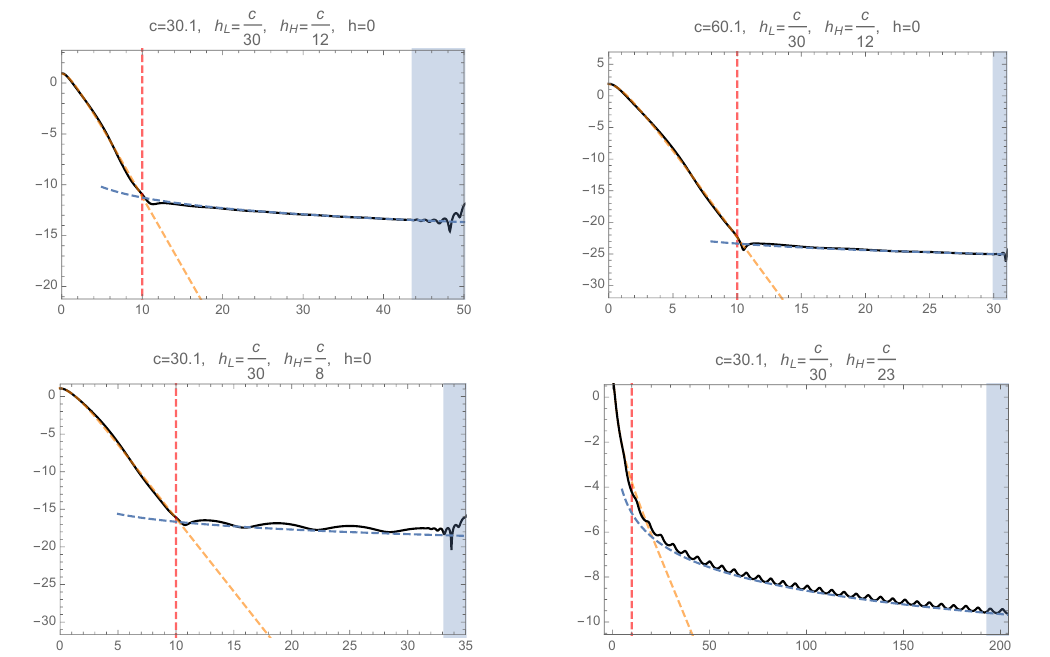
Figure 8 . Heavy-light Virasoro vacuum blocks switch from an initial exponential decay to a slow, universal power law decay at roughly the time scale t d = t D b , where the constant o(cid:11)set b depends (cid:0) on the choice of r in z = 1 re (cid:0) it . The vertical axis is log , while the horizontal axis is the (cid:0) jVj Lorentzian time t . The black lines are full Virasoro vacuum blocks computed to order q 1200 . This polynomial truncation stops converging in the shaded region. The yellow dashed lines are the semiclassical vacuum blocks using methods of [5]. The red dashed lines are the time scale (3.3). The blue dashed lines are the power law at (cid:0) 3 2 with a properly chosen to match the full